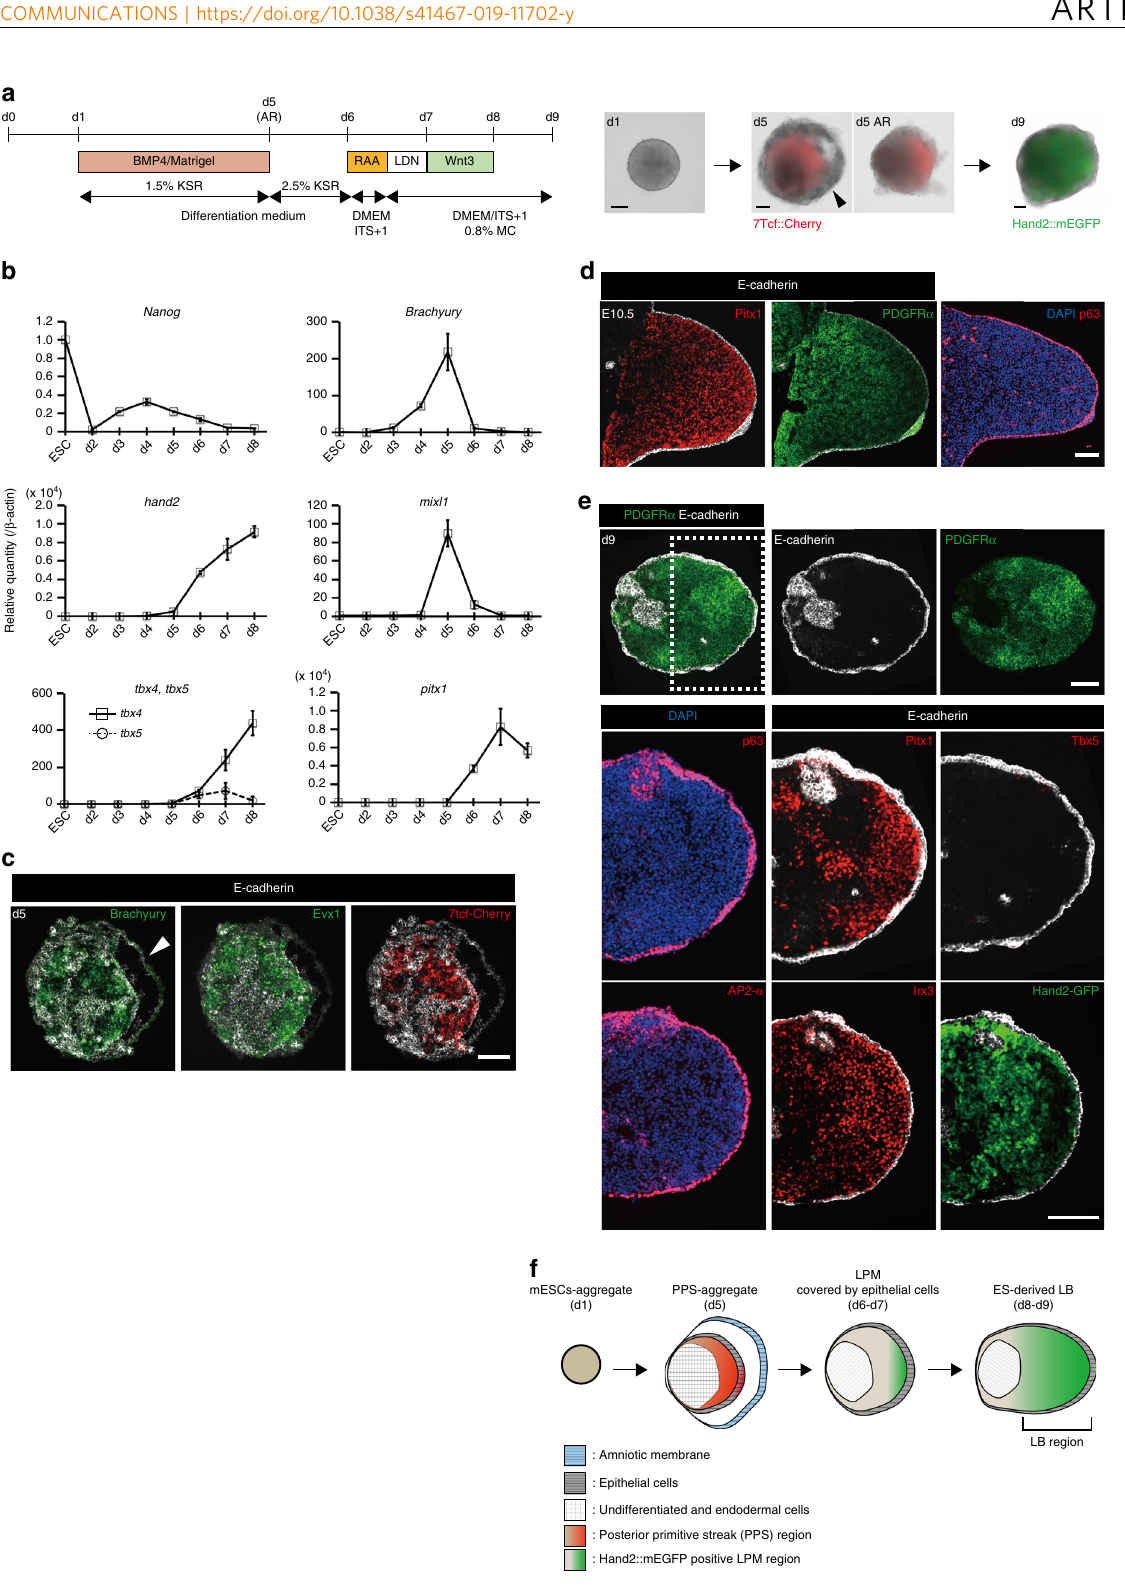
Fig. 1 Self-formation of a hindlimb bud-like tissue in 3D culture of mESCs aggregate. a Scheme for induction of HLB from mESCs aggregate (left), and bright- fi eld views (right). b qRT-PCR analysis of each marker in ES – HLB from day 2 to 8. (mean ± s.d, n = 3 independent experiments). c Cryosection of the mESC-derived PPS aggregate on day 5 was stained with E-cadherin, Brachyury, Evx1, and fl uorescence of 7Tcf::Cherry. d , e Immunostaining of D-V section of the E10.5 mouse hindlimb bud d and ES – HLB on day 9 (e; top, whole ES – HLB section; bottom, enlarged view of dotted box area). Hindlimb bud mesenchymal cells (Pitx1 + , PDGFR α + ) are covered by the epithelial layer (E-cadherin + , p63 + , AP2- α + ). Forelimb marker (Tbx5) is not expressed, and A- P markers (A: Irx3, P: Hand2::mEGFP) are expressed in ES – HLB. f Schematic differentiation process of ES – LB from mESCs aggregate. AR, amniotic membrane removed; LPM, lateral plate mesoderm; D-V, dorsal-ventral; A-P, anterior – posterior; mESCs, mouse embryonic stem cells; ES – HLB, mESC- derived hindlimb bud. Arrowheads indicate amniotic membrane. Scale bars, 100 μ